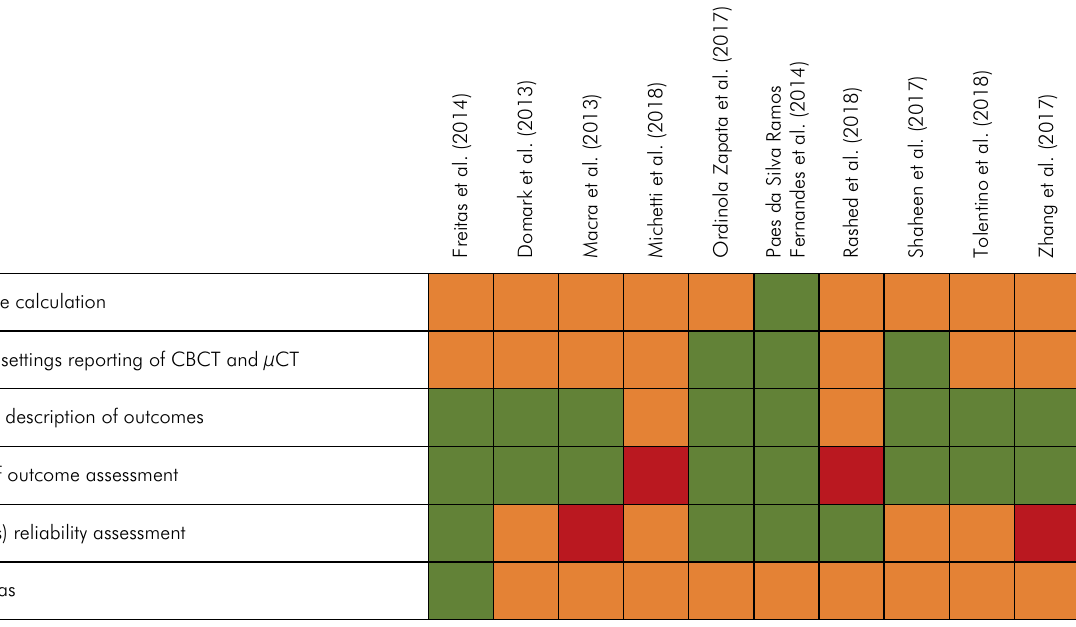
Figure 2. Risk of bias graph: Reviewers’ judgements about each risk of bias item presented across all included studies.